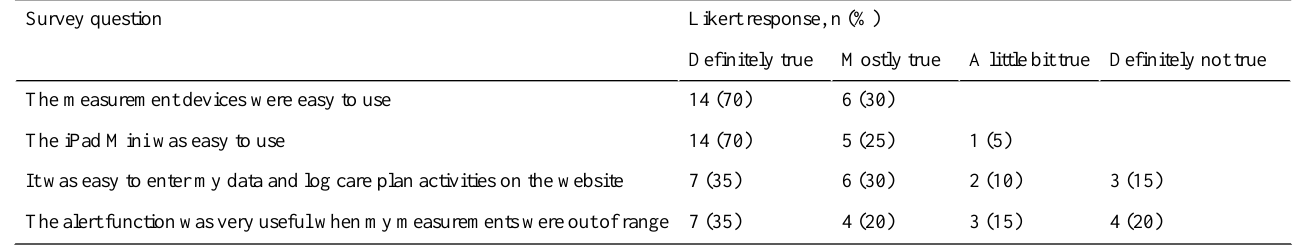
Table 4. Usability and satisfaction with specific components of the intervention as reported by study participants